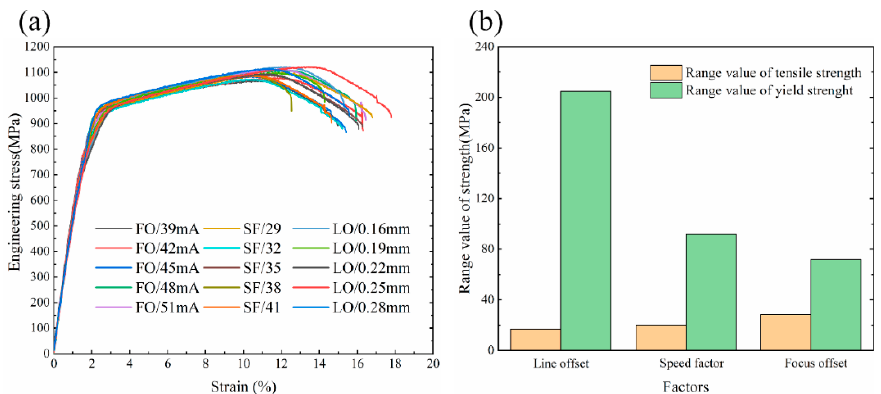
Figure 14. Tensile mechanical properties of Ti-6Al-4V at ambient temperature: ( a ) influence of process parameters on strength; ( b ) tensile true stress–strain curve.